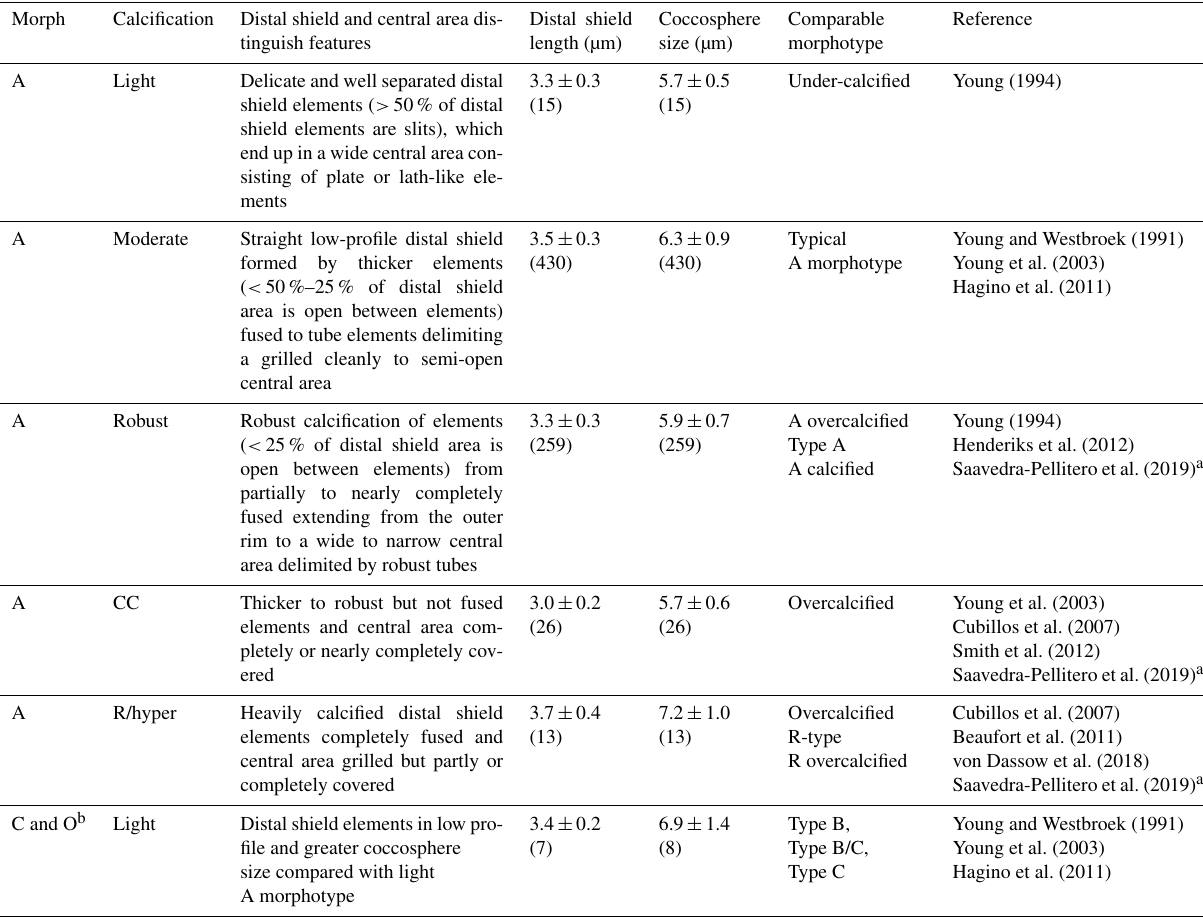
Table 1. Classification of E. huxleyi coccospheres based on the calcification level of coccoliths. Mean ± standard deviations of distal shield length and coccosphere diameter of morphotypes observed in Patagonia are given for coccospheres where at least one distal shield was visible and adequately oriented (numbers in